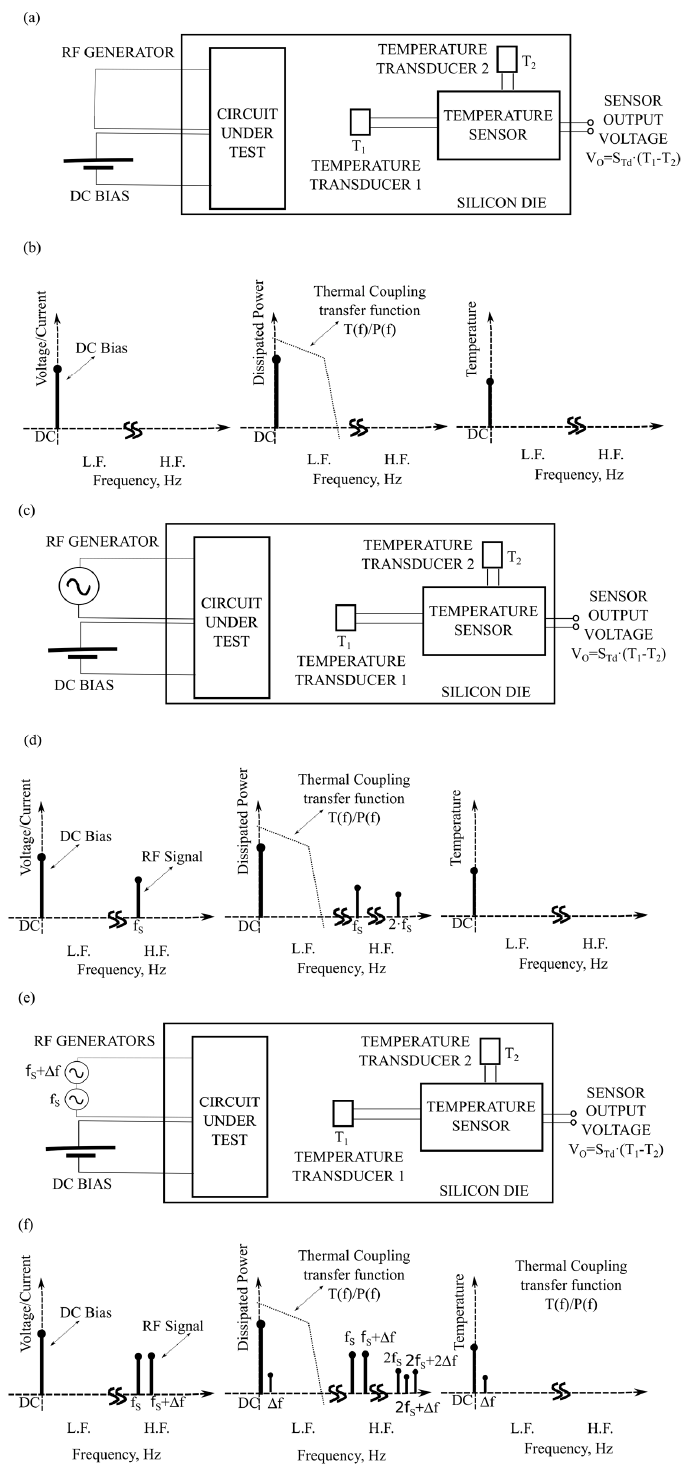
Figure 2. Three different techniques to measure CUT properties by thermal measurements: ( a , b ), by applying only DC and measuring DC temperature; ( c , d ), by applying DC and one signal tone and measuring DC temperature—Homodyne technique; and ( e , f ), by applying DC and two-signal-tones- separated Δ f and measuring the temperature spectral component at Δ f —Heterodyne technique.